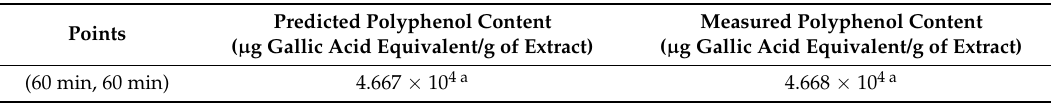
Table 2. Confirmation results of the model with the measured values and the predicted values of the studied responses.